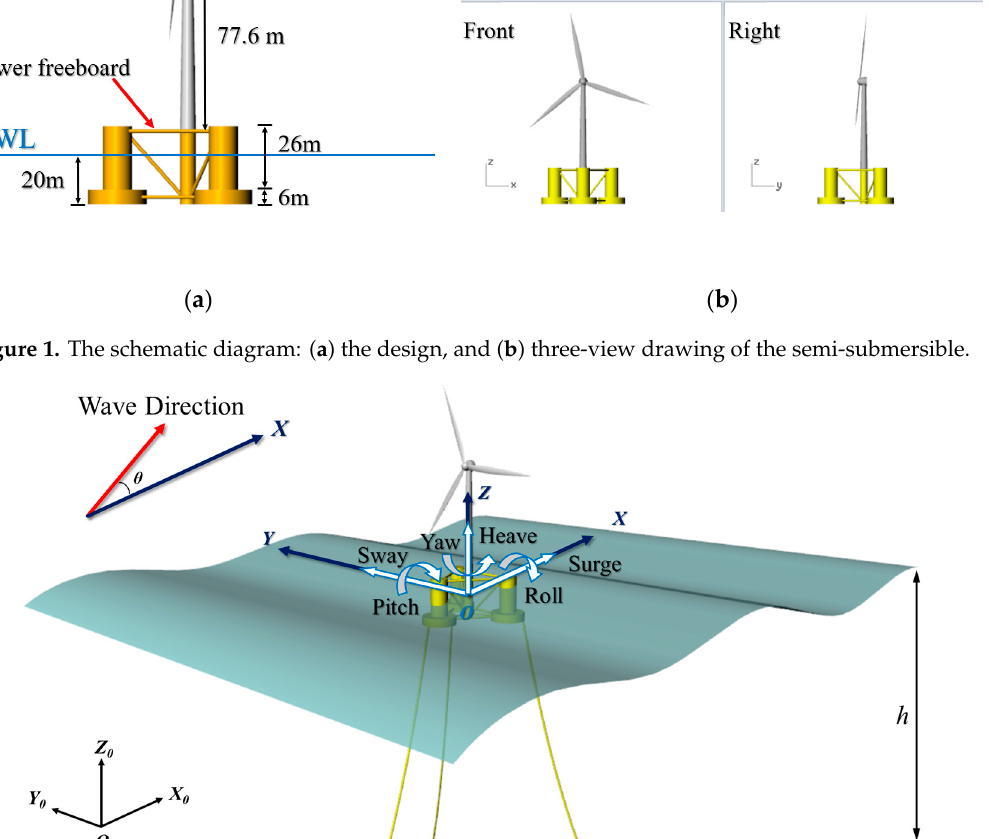
Figure 1. The schematic diagram: ( a ) the design, and ( b ) three-view drawing of the semi-submersible.